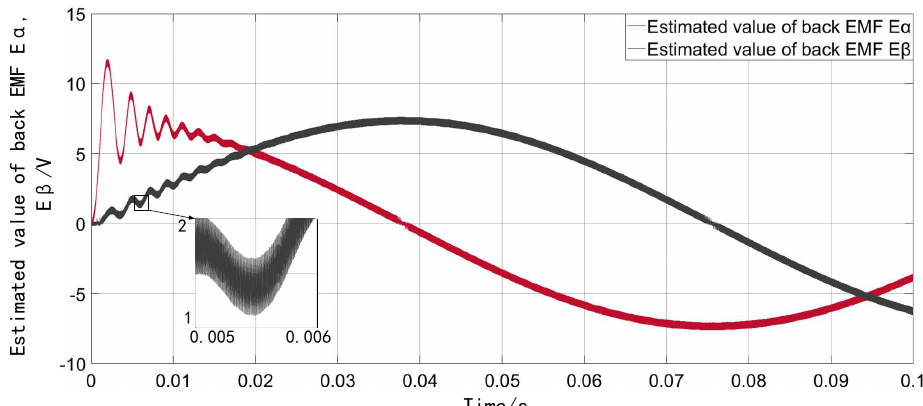
Figure 17. The variation curve of the estimated value of two opposite electromotive forces at low speed of the traditional SMO.